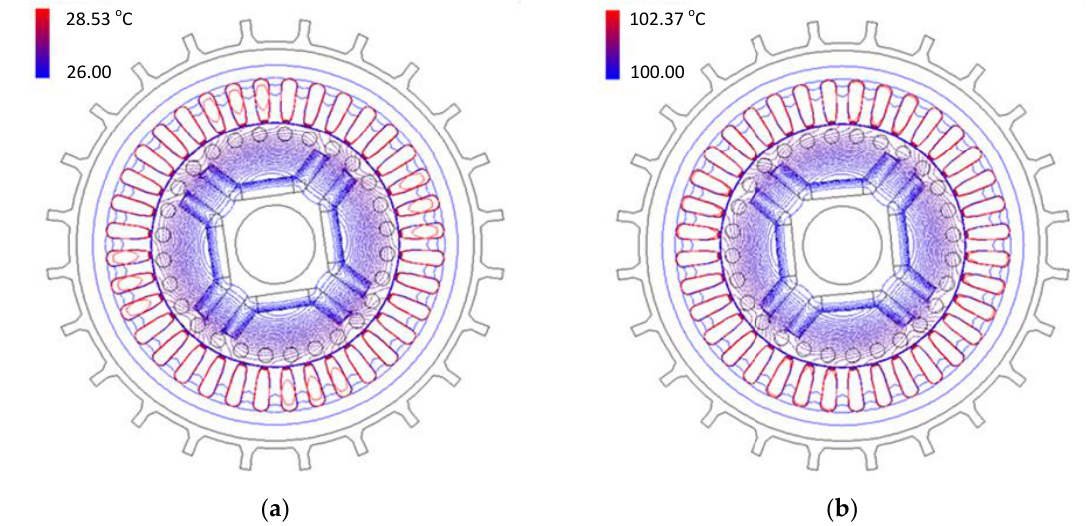
Figure 12. Temperature distribution in an electromechanical steady-state after start-up for t = 0.6 s, J i = 0.041 kgm 2 , T L = 0 Nm: ( a ) τ i = 26 ◦ C, ( b ) τ i = 100 ◦ C.